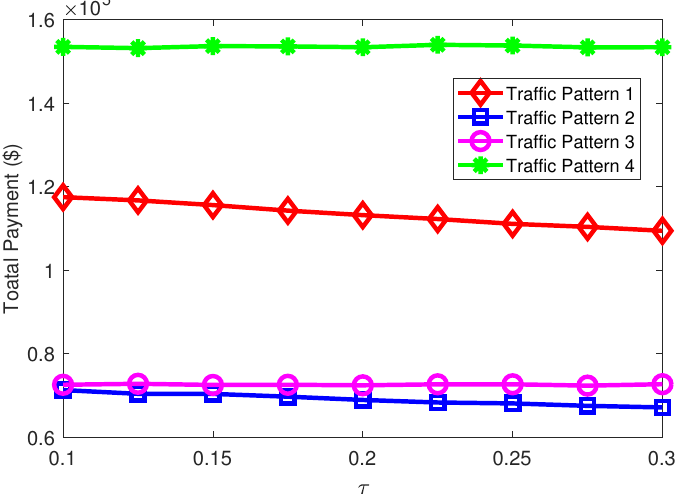
Figure 14. Impact of τ on total payment in PARM.